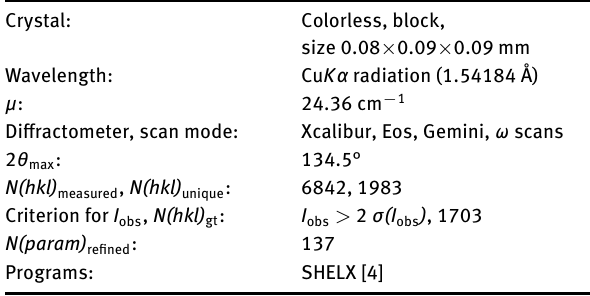
Table 1: Data collection and handling.